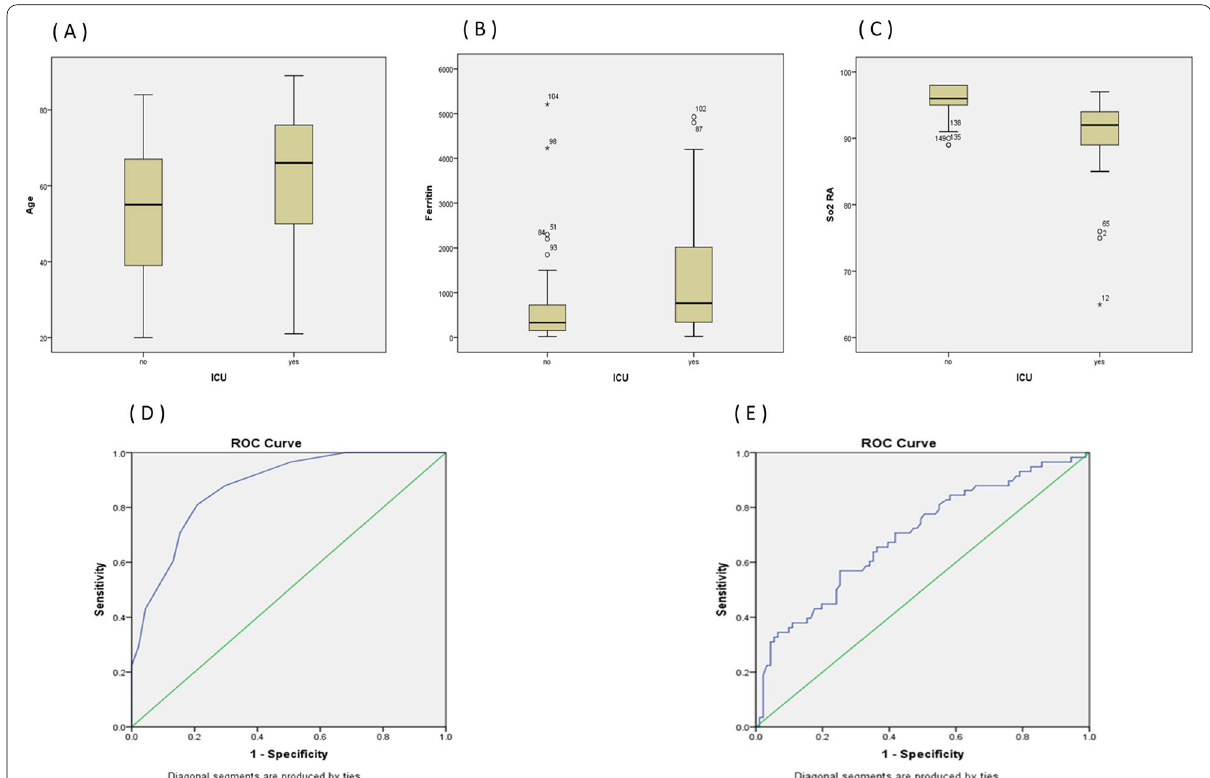
Fig. 1 A Boxplot for age distribution in relation to ICU admission. B Boxplot for serum ferritin distribution in relation to ICU admission. C Boxplot for baseline oxygen saturation distribution in relation to ICU admission. D Receiver operator characteristics (ROC) curve for baseline oxygen saturation in patients admitted to ICU. E Receiver operator characteristics curve for Serum Ferritin in patients admitted to